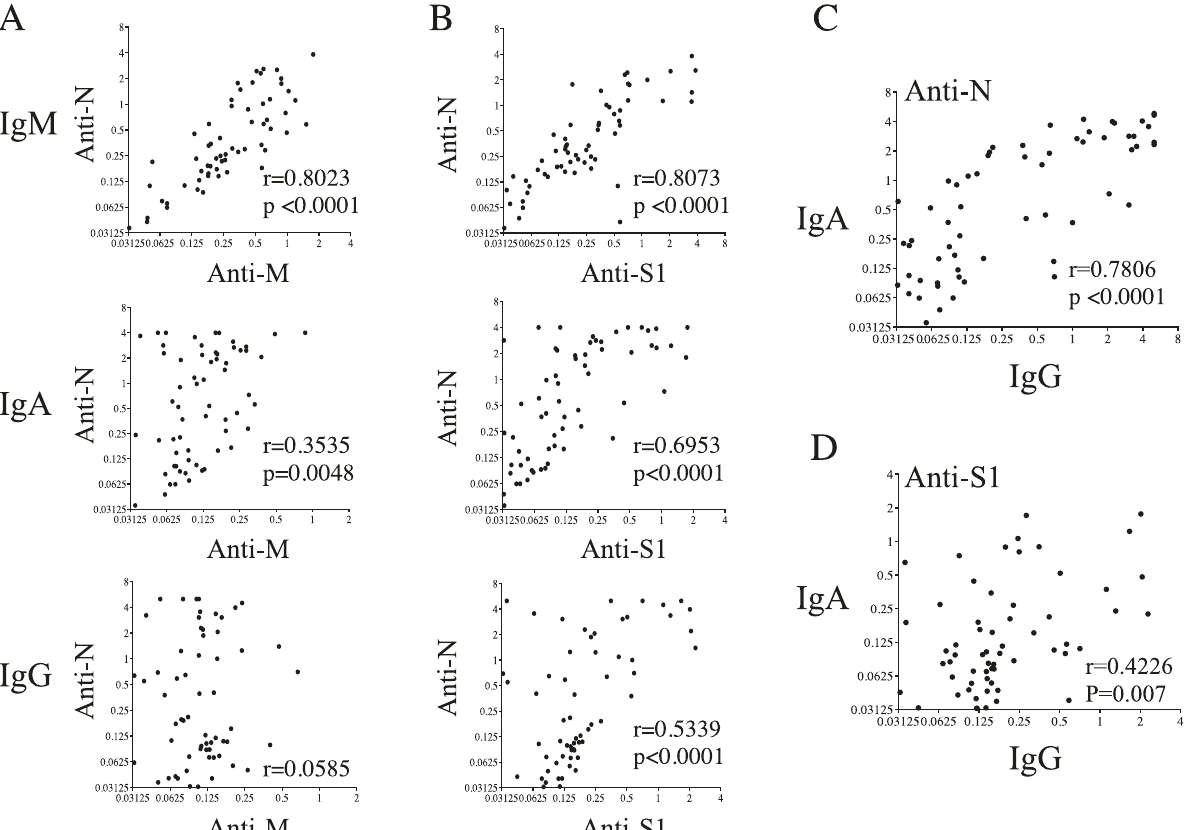
Fig. 2 Correlations between humoral responses. IgM, IgA, and IgG responses against A N versus M and B N versus S. Top: IgM antibodies; Middle, IgA antibodies; and Bottom, IgG antibodies. Correlations between speci fi c IgA and IgG antibodies against C N and D S1 antigens. Values are derived from Fig. 1. OD optical density. Each dot represents an individual. Correlations were assessed using the Spearman test and r is